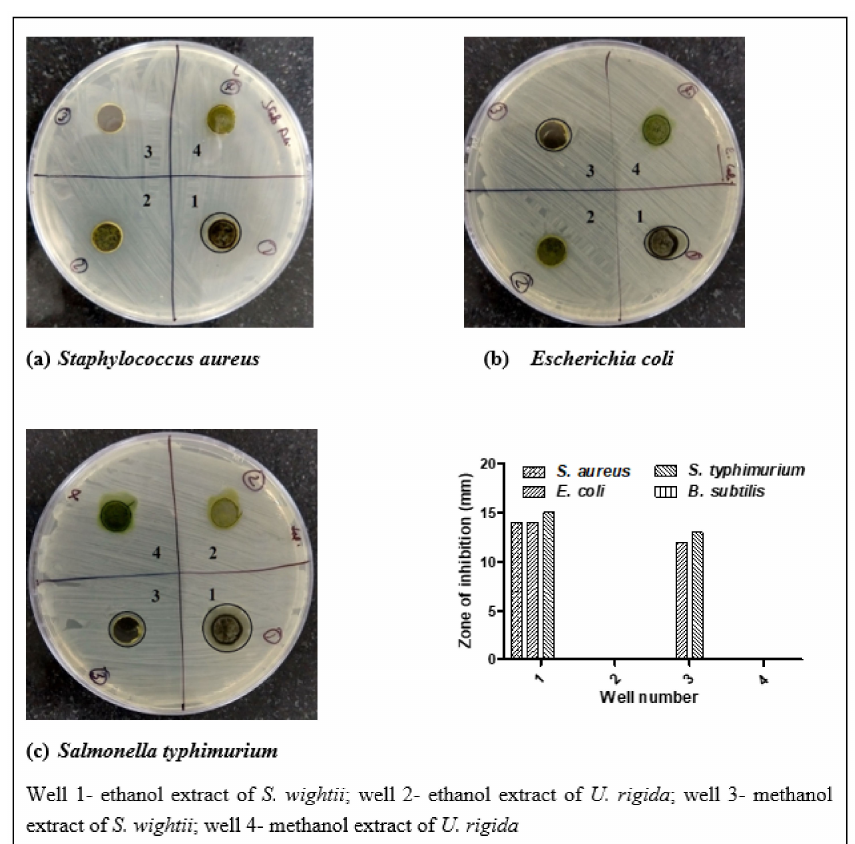
Figure 1. Antimicrobial activity of ethanol and methanol extracts of S. wightii (wells 1 and 3) and U. rigida (wells 2 and 4), respectively, against S. aureus ( a ), E. coli , and ( b ) S. typhimurium ( c